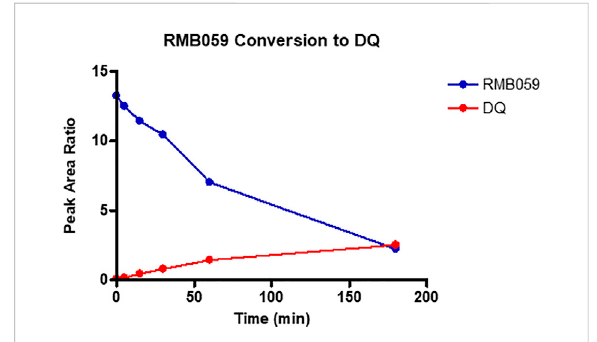
FIGURE 2 Conversion of RMB059 into DQ during 3-hour incubation in human